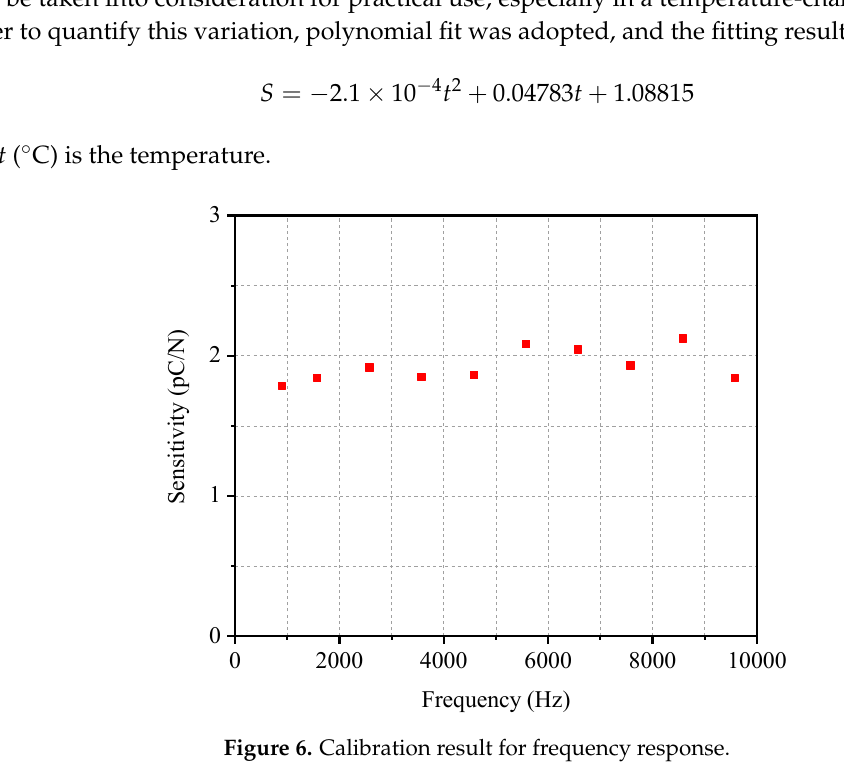
Figure 6. Calibration result for frequency response.